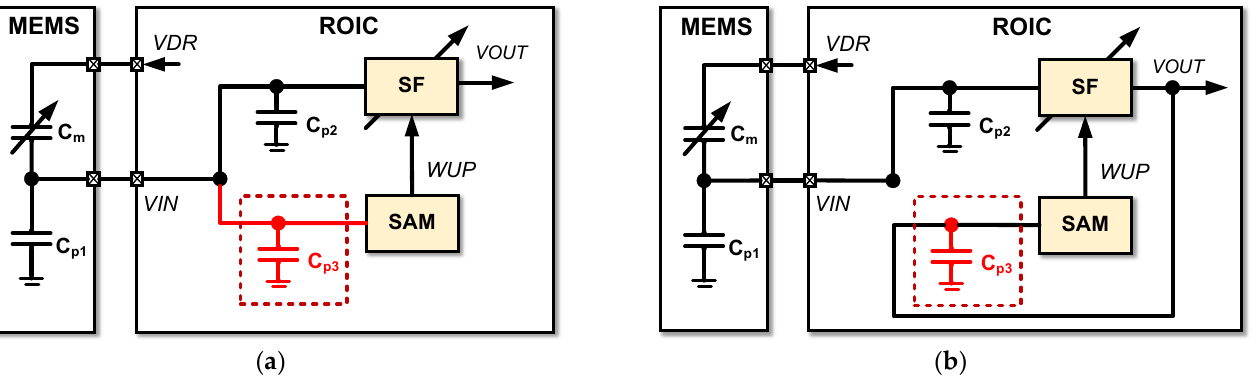
Figure 3. Architecture approach 1: ( a ) Configuration when SF and SAM share MEMS input terminal; ( b ) Configuration when MEMS input connects only to SF.